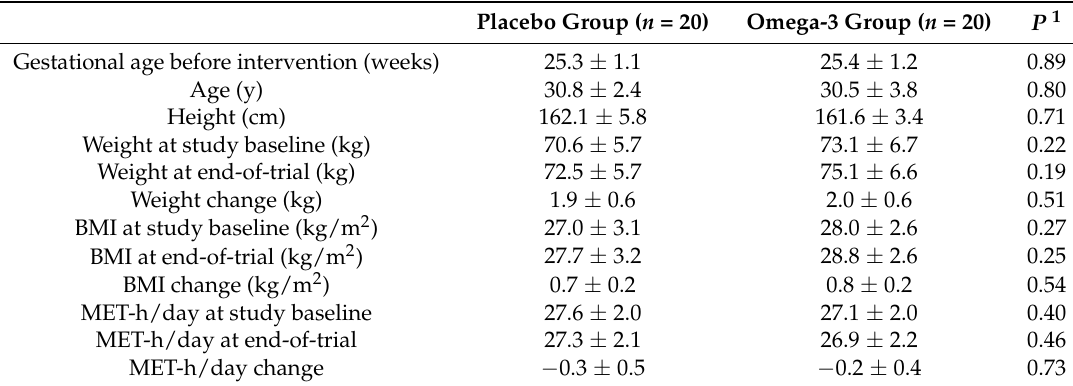
Table 2. General characteristics of study participants.